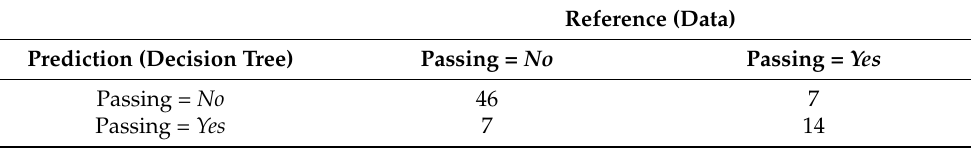
Table 8. Confusion matrix corresponding to the decision